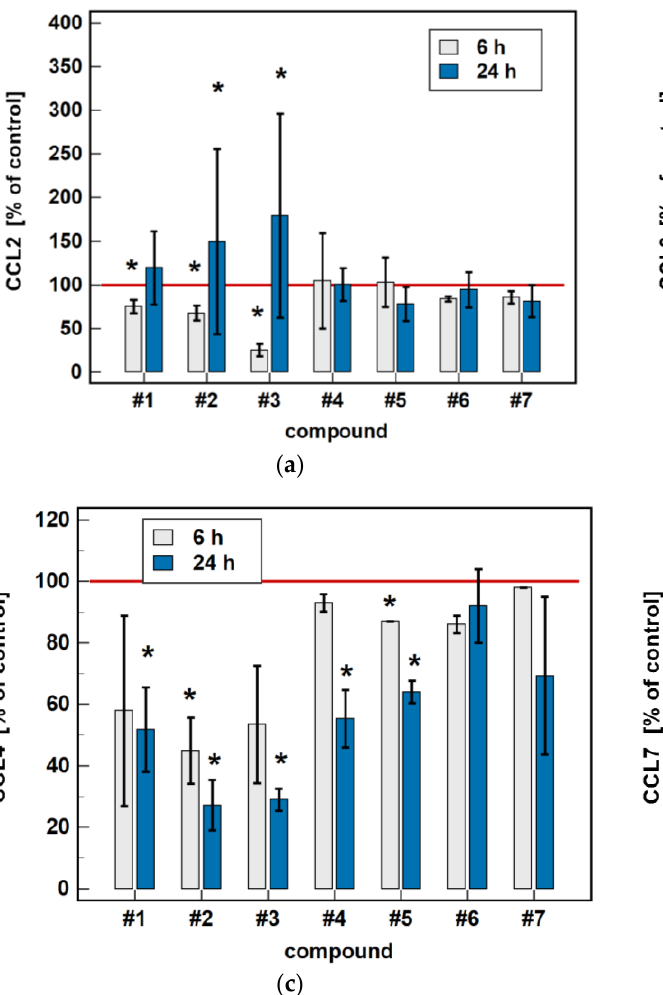
Figure 7. Time-dependent effect of oxicams on MCPs and MIPs secretion in Caco-2 cells: ( a ) MCP-1/CCL2; ( b ) MIP- 1α/CCL3; ( c ) MIP- 1β/CCL4; ( d ) MCP-3/CCL7. The bars represent the mean ± SD (whiskers) ratio of the chemokine concentration in the medium from cells treated with 200 μM oxicams for 6 and 24 h, as compared to untreated controls, expressed as a percentage. The significant differences between the secretion from treated and untreated cells, analyzed using a t -test for one mean, are indicated by asterisks (*). The reference secretion of the control cells is indicated by a red solid line. Compound # 6 denotes piroxicam, and # 7 denotes meloxicam.